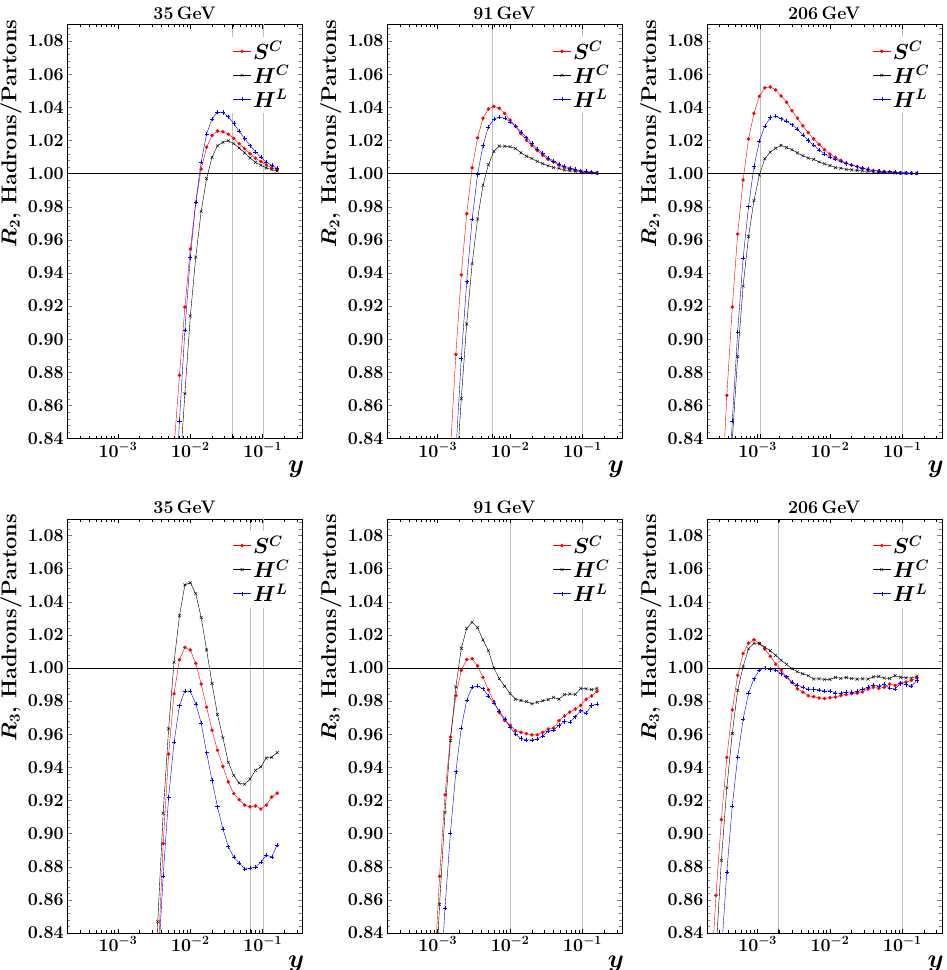
Figure 13 . Hadronization corrections obtained with S C , H C and H L hadronization models. For every (cid:12)xed y in the (cid:12)t range the deviation from unity decreases monotonically with increasing centre-of-mass